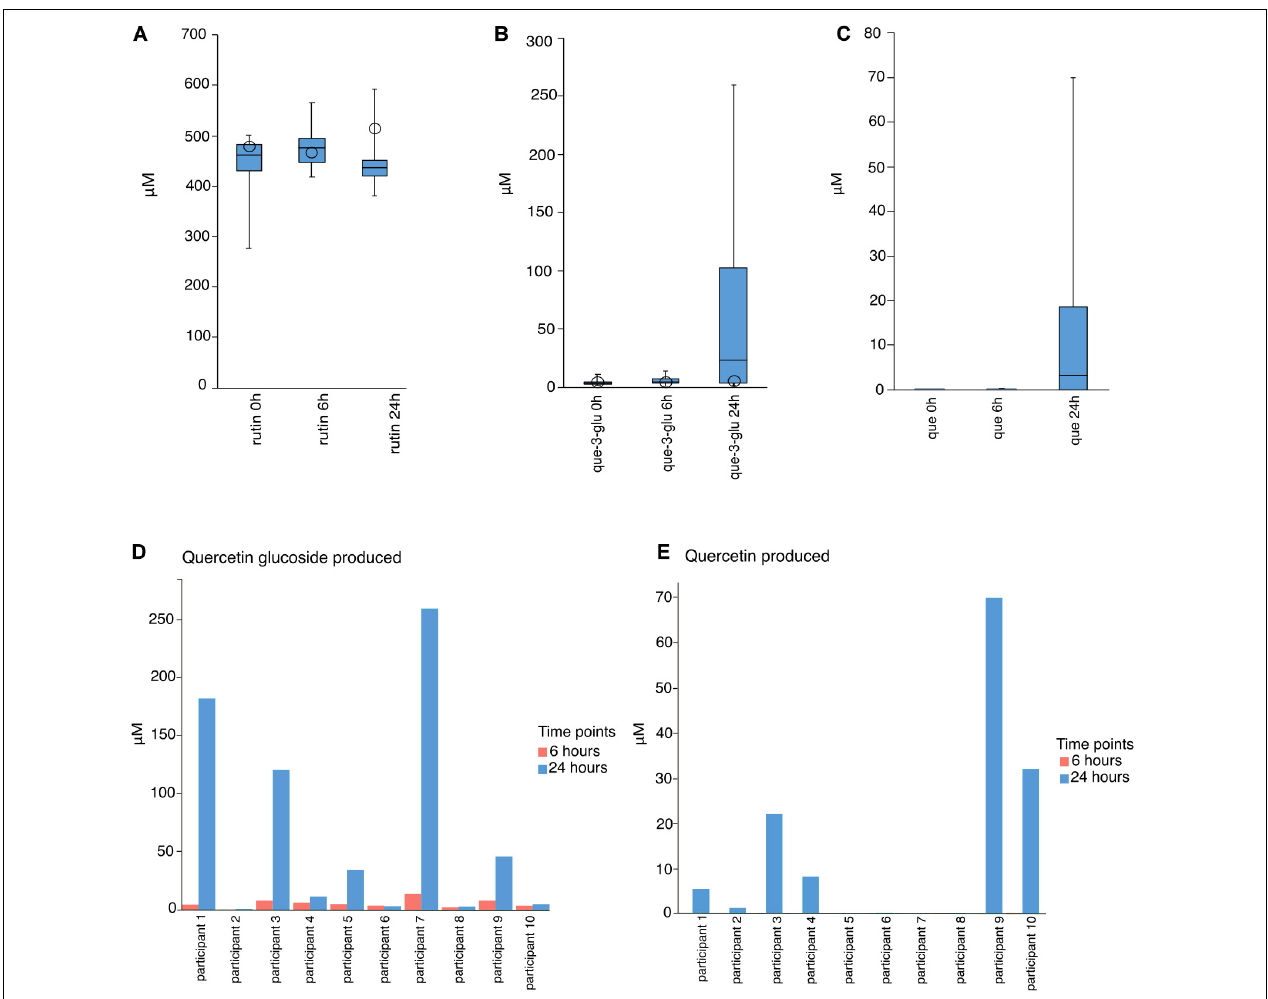
FIGURE 2 | Molar concentrations of rutin, quercetin-3-glucoside (Q-glc), and quercetin (Q) after 0, 6, and 24 h incubation. (A–C) Box and whisker plots of the combined results of incubation of rutin with the gut microbiota of 10 participants, as obtained from LC-HRMS analysis. Open circles indicate results of abiotic controls. (D) Q-glc and (E) Q concentrations in each incubation after 6 and 24